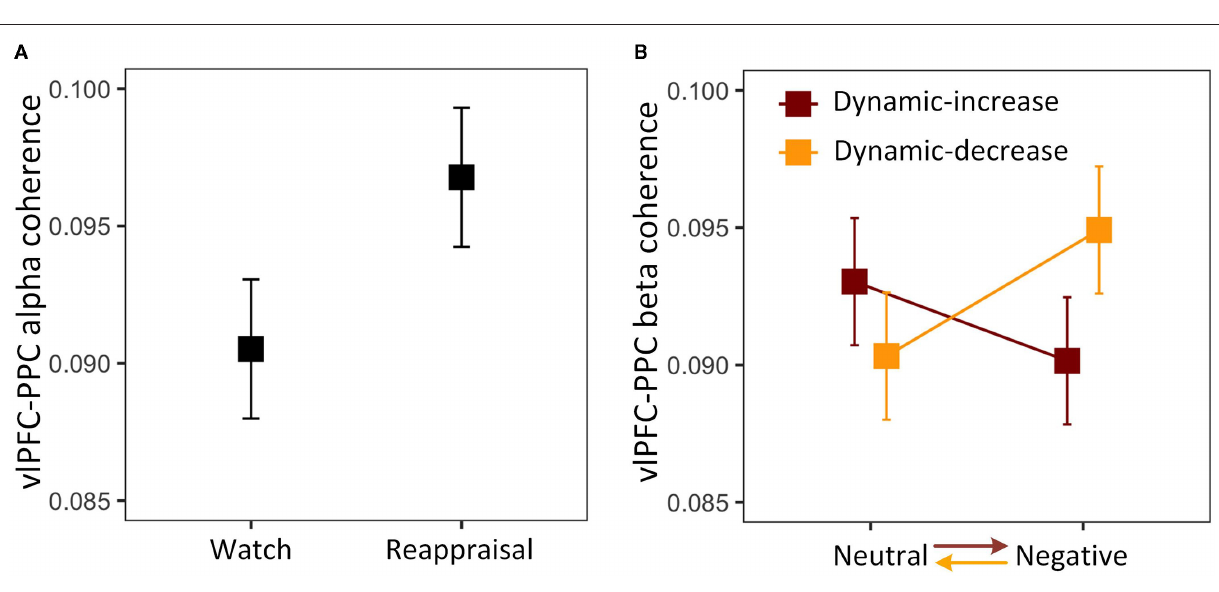
FIGURE 3 | (A) Main effect of reappraisal task on the alpha band FC between the ventrolateral prefrontal cortex (vlPFC) and the posterior parietal cortex (PPC); (B) two-way interaction plot of model estimates of content and context on the beta band FC between vlPFC and PPC. Error bars are standard